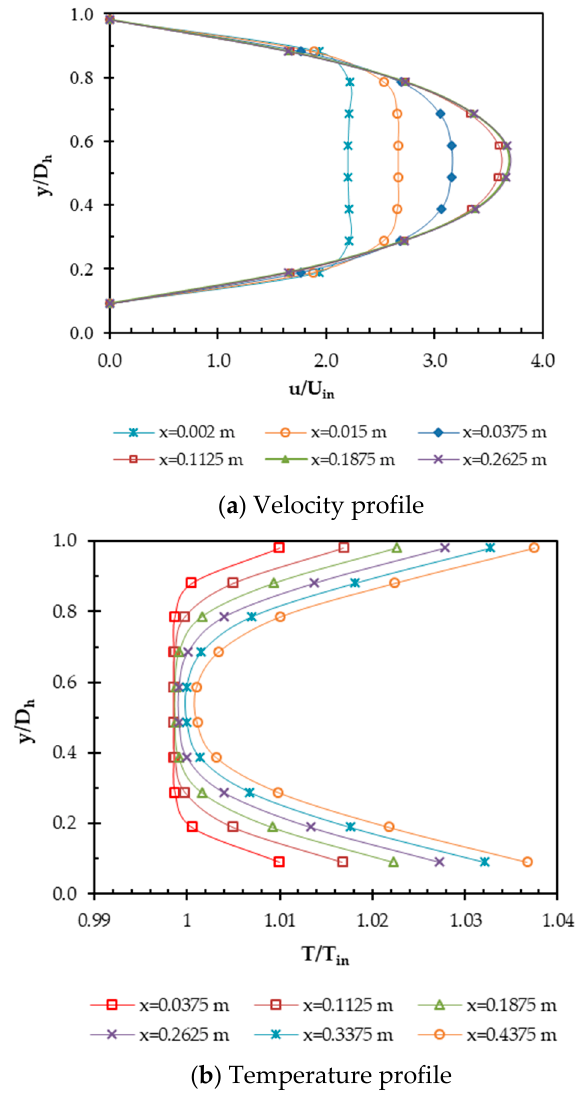
Figure 8. Radial distribution of velocity ( a ) and temperature ( b ) in the radial direction for 0.01 vol.% and a Reynold’s number of 1000.